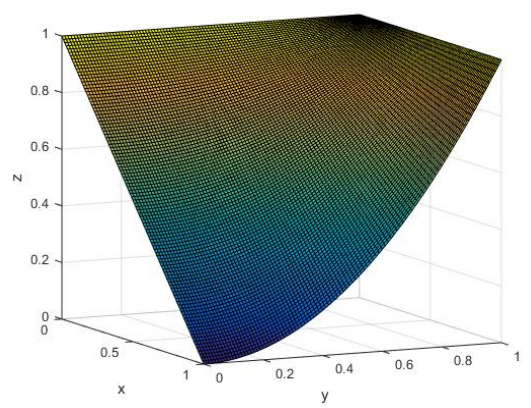
Figure 1. I implication of example 2.